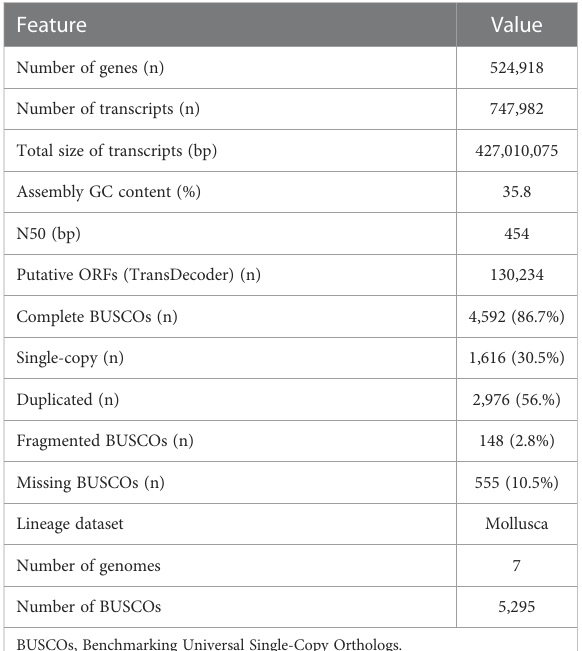
TABLE 4 Summary statistics of transcriptome